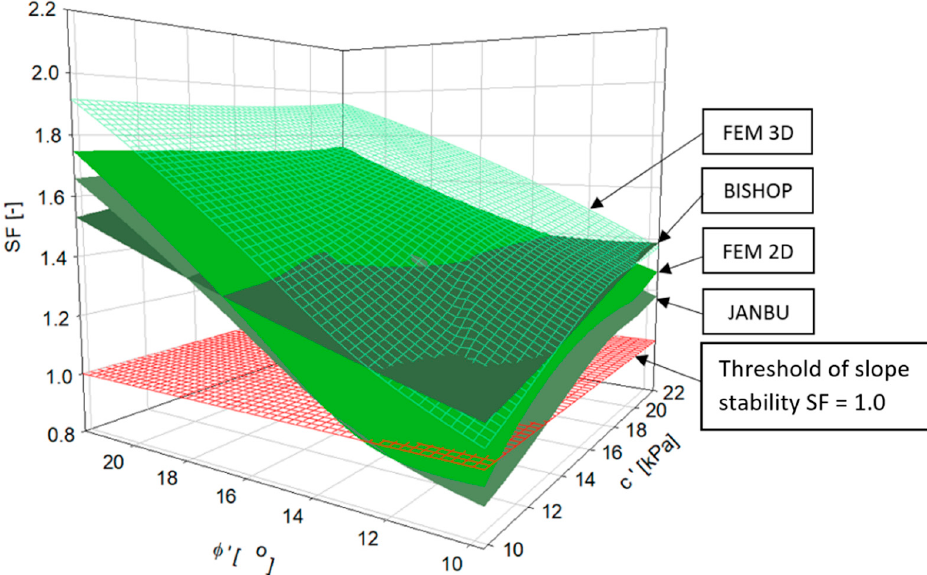
Figure 7. The three-dimensional dependencies of SF on the value of the internal friction angle and cohesion for different calculation methods.